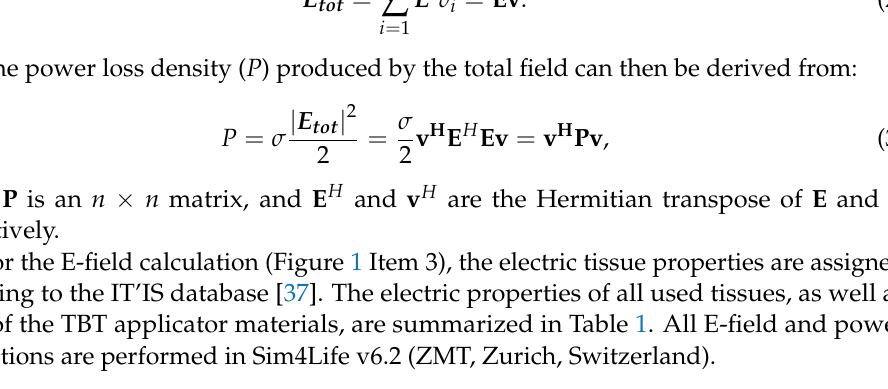
Table 1. Electric and thermal properties of the applicator materials and the tissues used in the